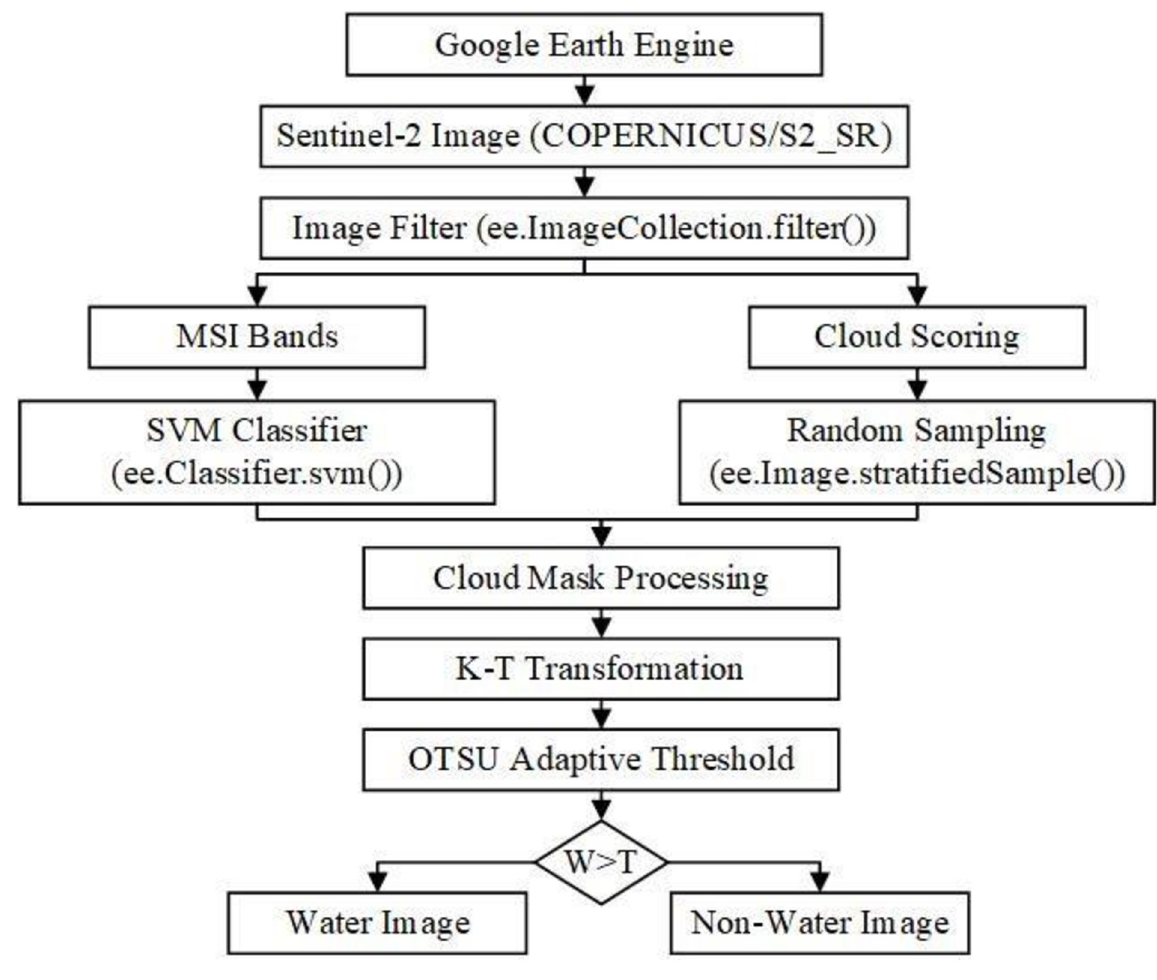
Fig 5. Flow chart of the AWECE.